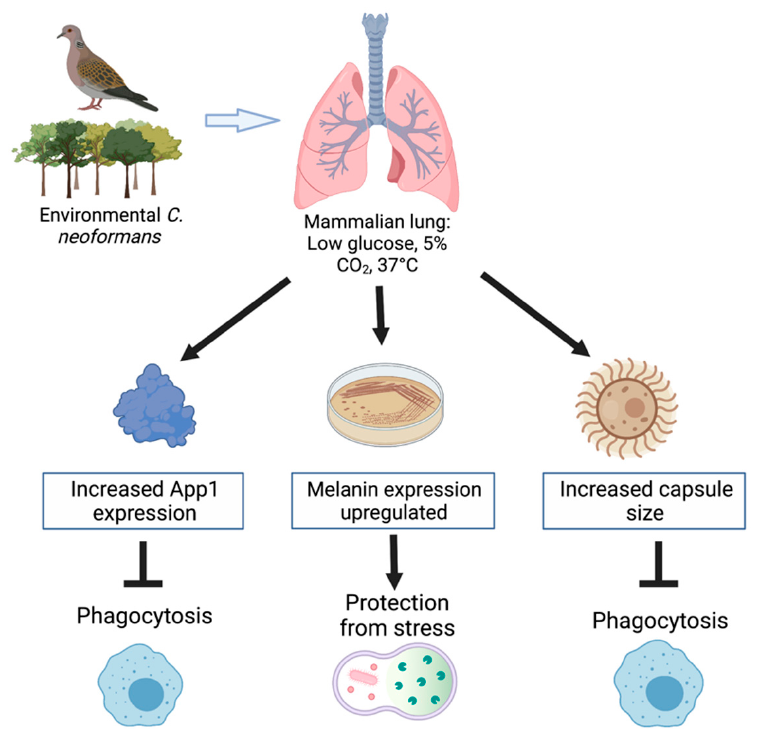
Figure 1. The mammalian lung environment alters the expression of virulence factors resulting in protection from the host’s immune response. Figure created with BioRender.com.